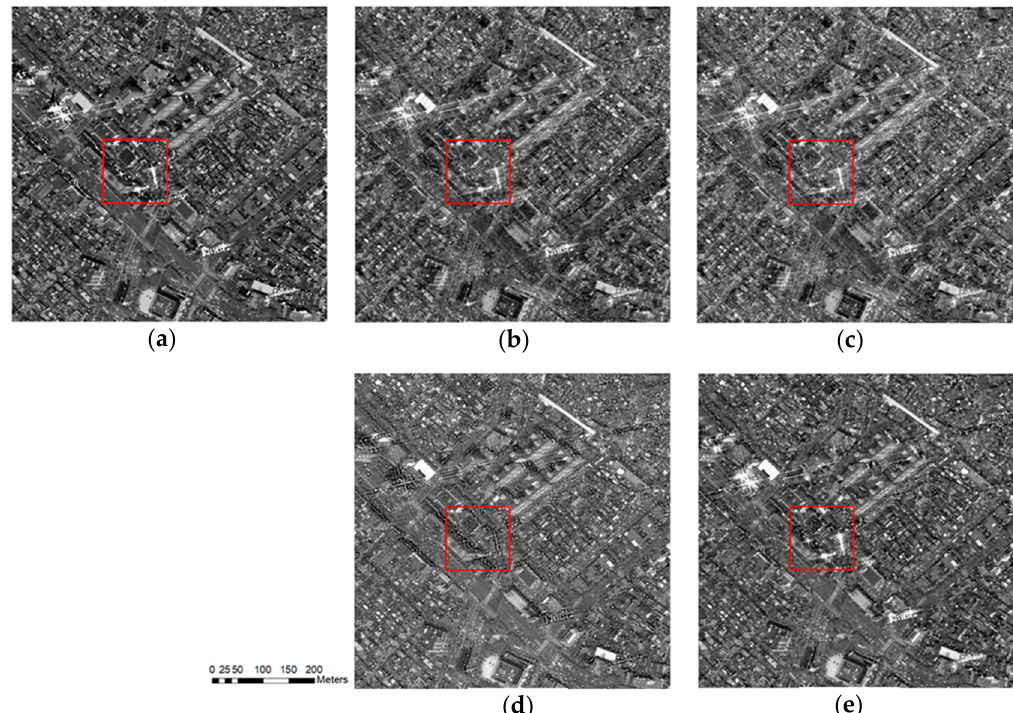
Figure 8. Comparison with the results of image fusion for Site 3: ( a ) proposed method; ( b ) a-trous wavelet decomposition; ( c ) discrete wavelet transform; ( d ) non-subsampled contourlet transform; and ( e ) non-subsampled contourlet transform-pulse couple neural network.